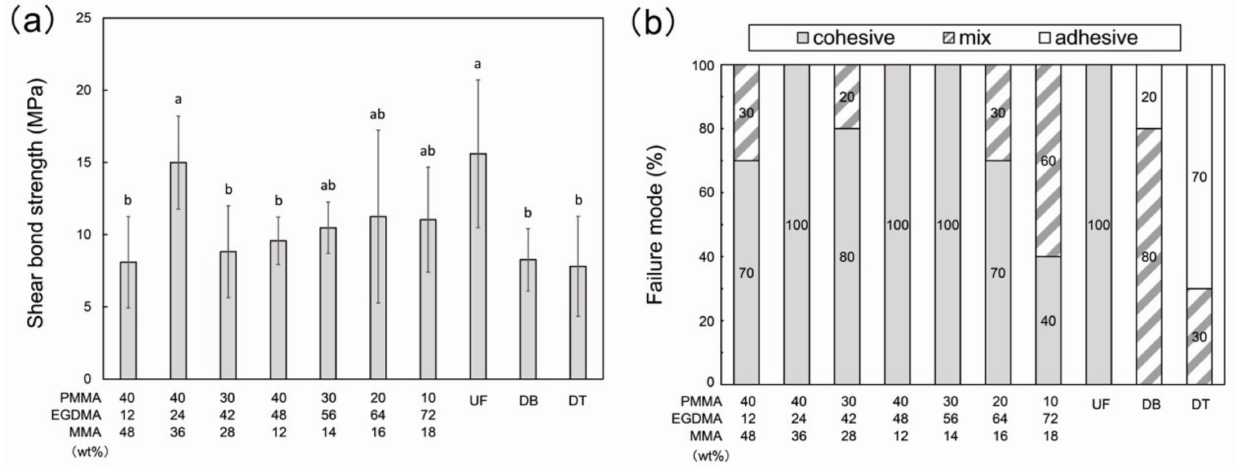
Figure 4. Bonding properties of printable PMMA-based resins, conventional PMMA (UF), and commercial 3D-print resins (DB and DT); ( a ) shear bond strength (SBS) of each sample and self-cured resin; and ( b ) sample failure modes. The different letters in the figure indicate significant differences between the groups ( p < 0.05, Tukey’s test, n =